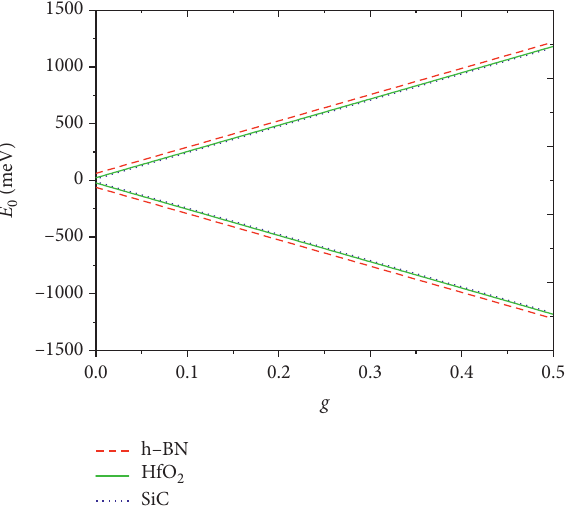
Figure 5: Variable parameter of Coulomb potential g versus the ground energy E 0